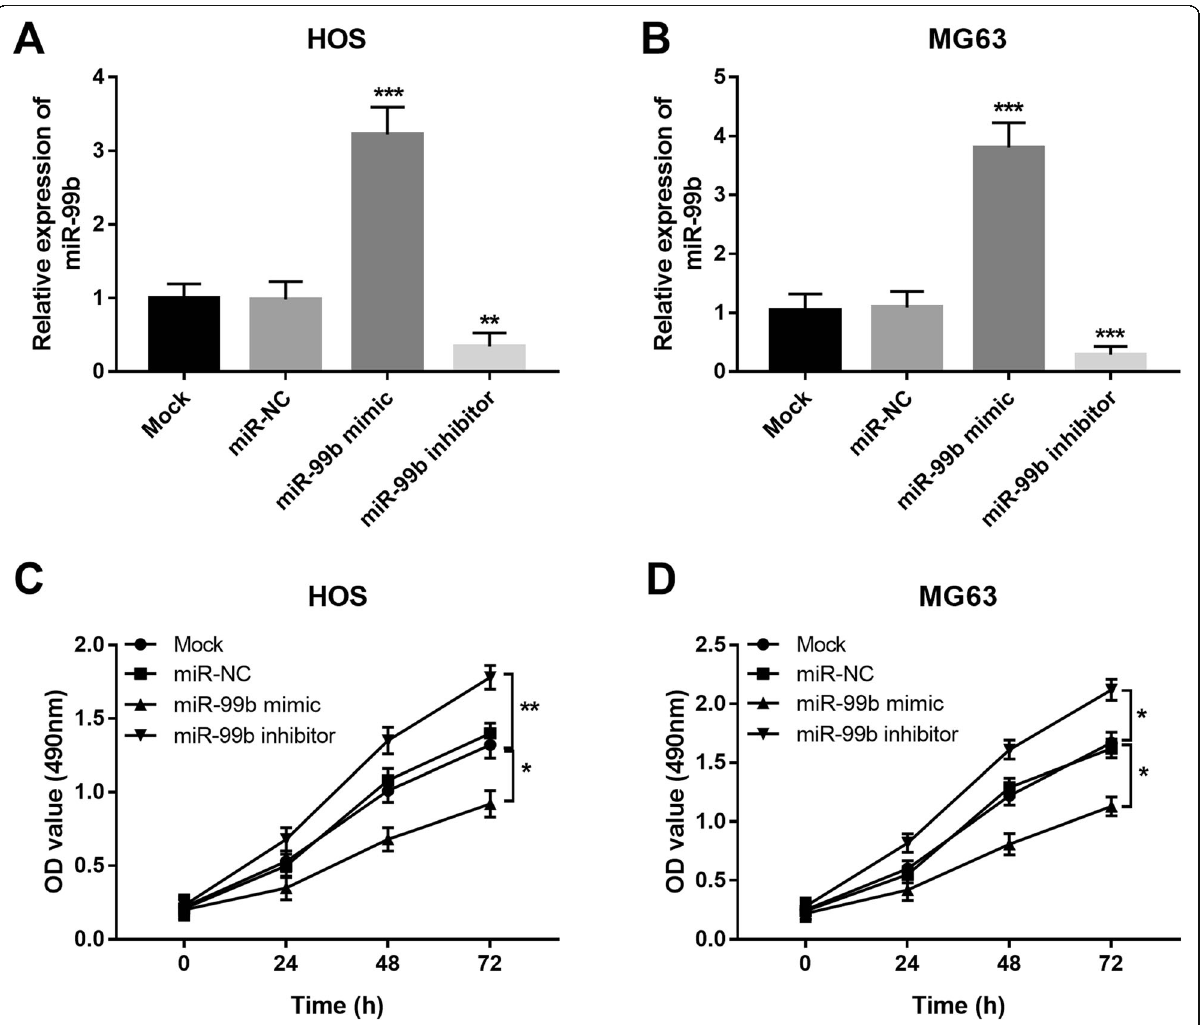
Fig. 3 Effects of miR-99b on cell proliferation of HOS and MG63 cells. a and b Expression of miR-99b was upregulated by the miR-99b mimic, but was downregulated by the miR-99b inhibitor. c and d Tumor cell proliferation was promote by the downregulation of miR-99b, while was inhibited by the upregulation of miR-99b. * P < 0.05, ** P < 0.01, ** P <